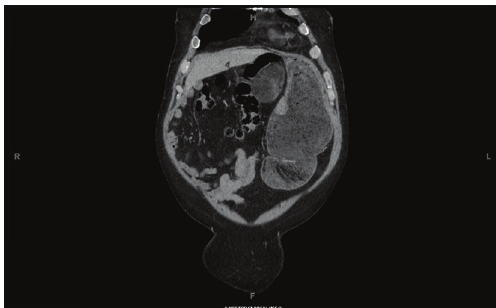
Figure 2: Computed tomographic coronal image showing epigas- tric mass abutting dilated stomach and duodenum.